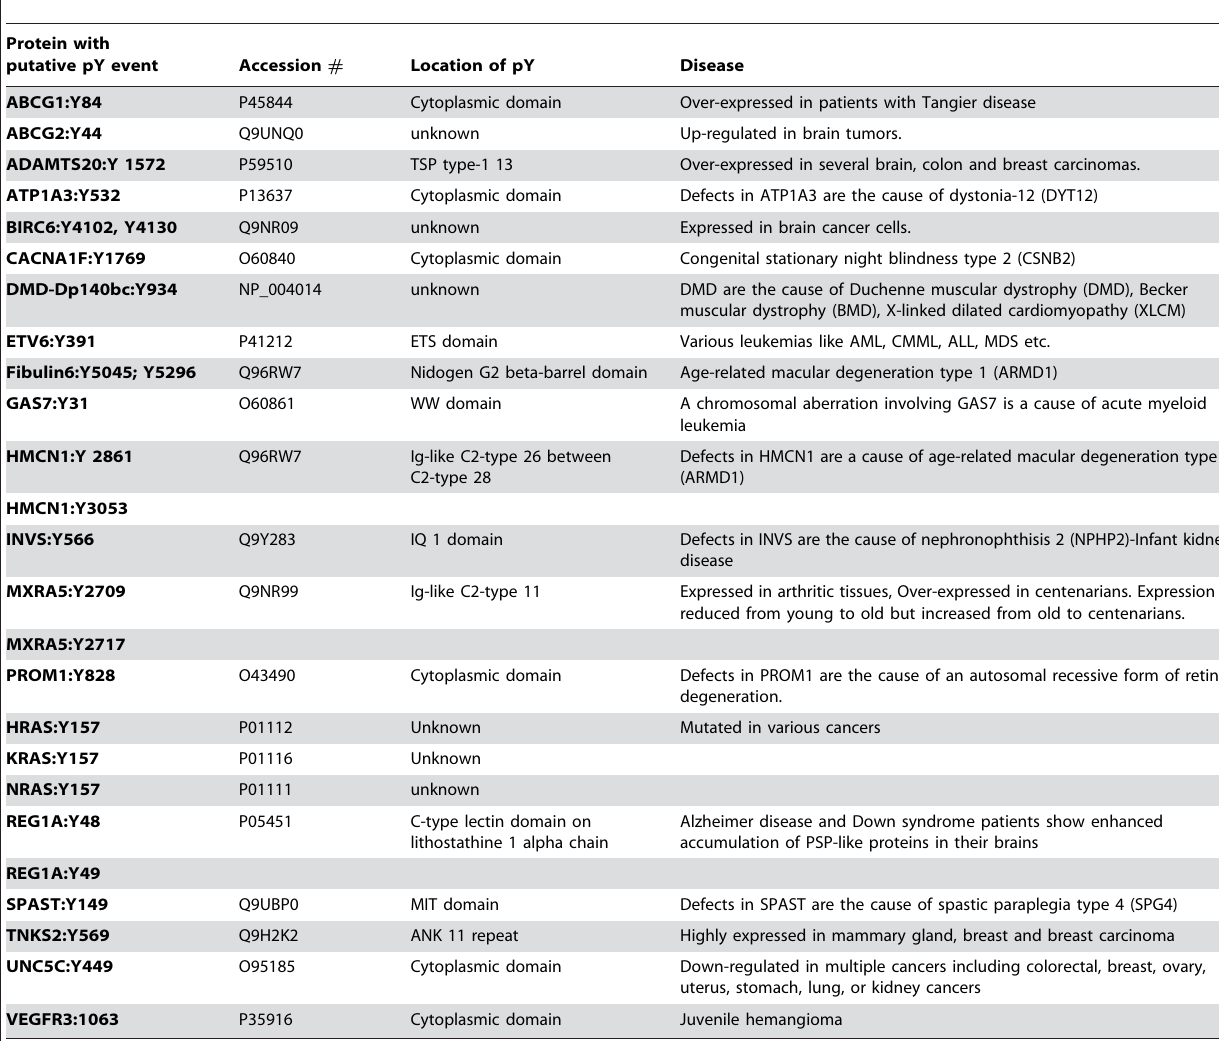
Table 2. Selected list of important human proteins with conserved fly yrosine phosphorylation involved in disease phenotypes.